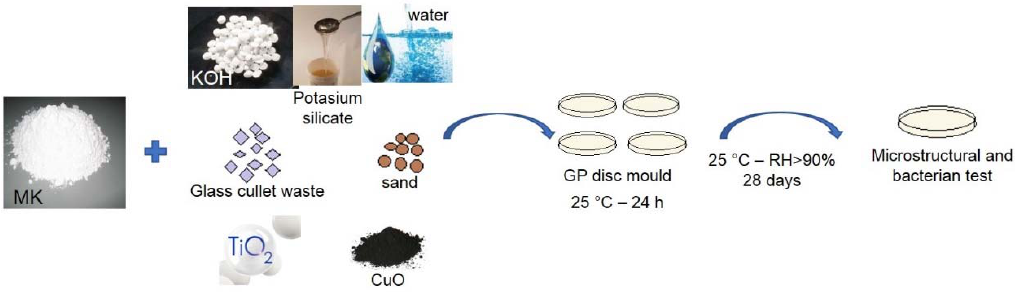
Figure 1. Diagram of the methodology used to synthesize the CuO nanoparticles via the Pechini method.